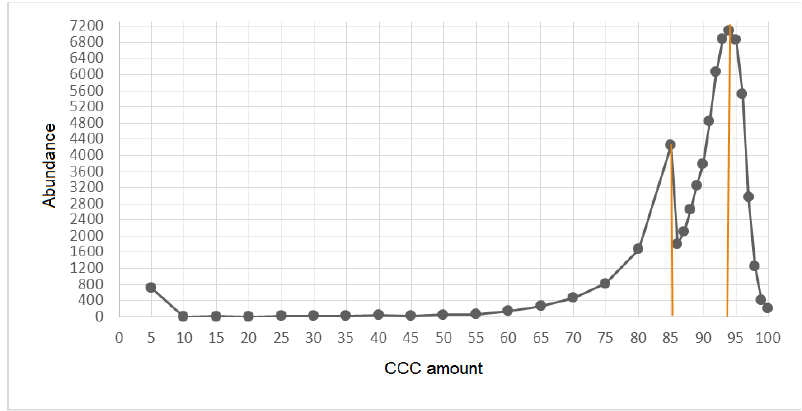
Figure 8. The histogram of CCC index value in one month of the examined